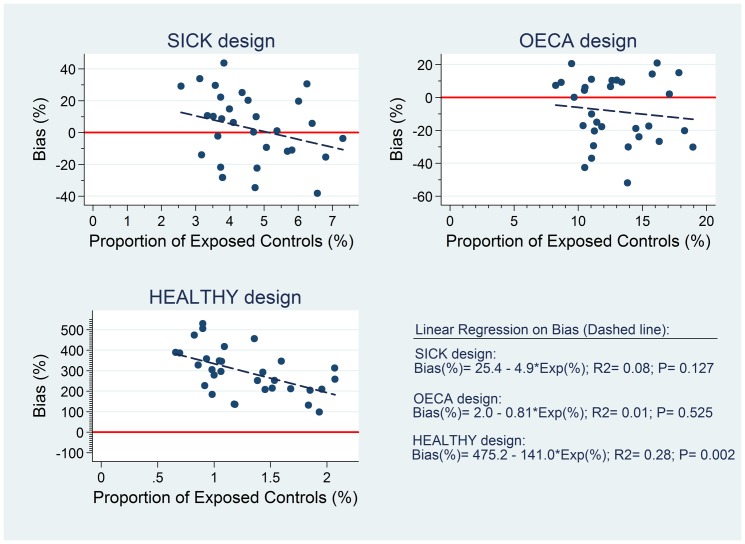
Bias in SICK, OECA and HEALTHY designs.The potential bias (%) is shown as a function of the proportion of exposed controls to acetaminophen (%) in the 31 birth defect groups and for the three evaluated designs. The linear function is defined as follows: Bias(%) = β0+β1*Exp(%); R-squared (R2) and the overall P value for the regression model are shown for each design.